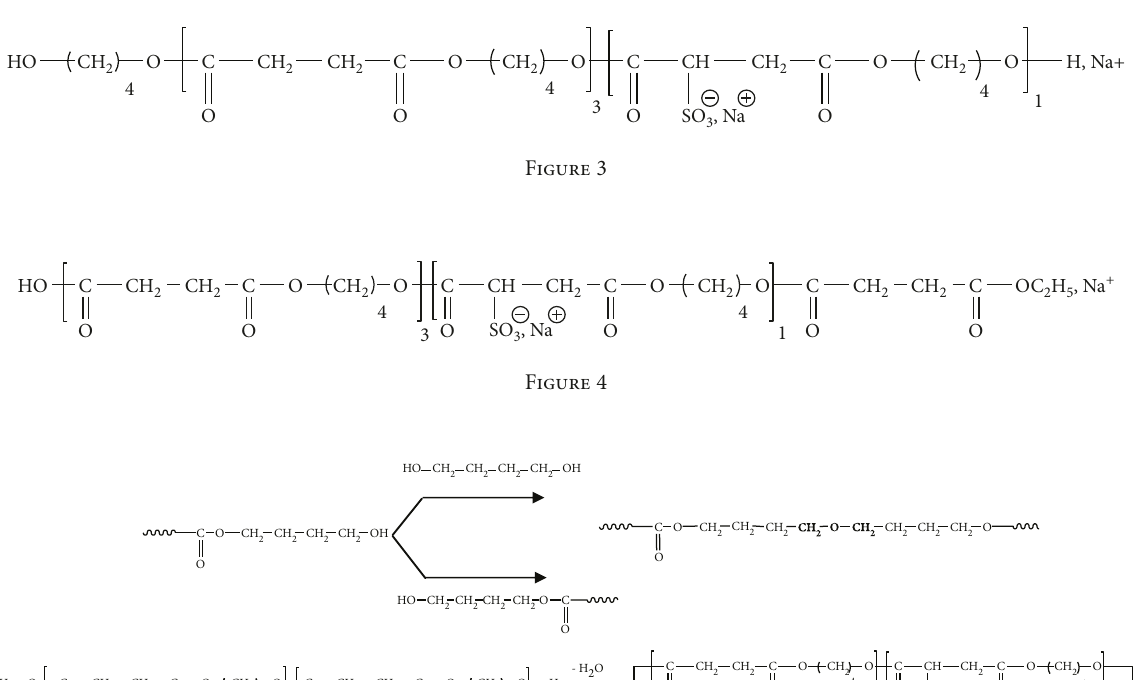
Figure 2: MALDI-TOF MS spectrum of PBSu